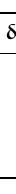
Table 4. Summary of some dynamic mechanical thermal properties of PLA-HNTs composites with di ff erent HNTs loading obtained by